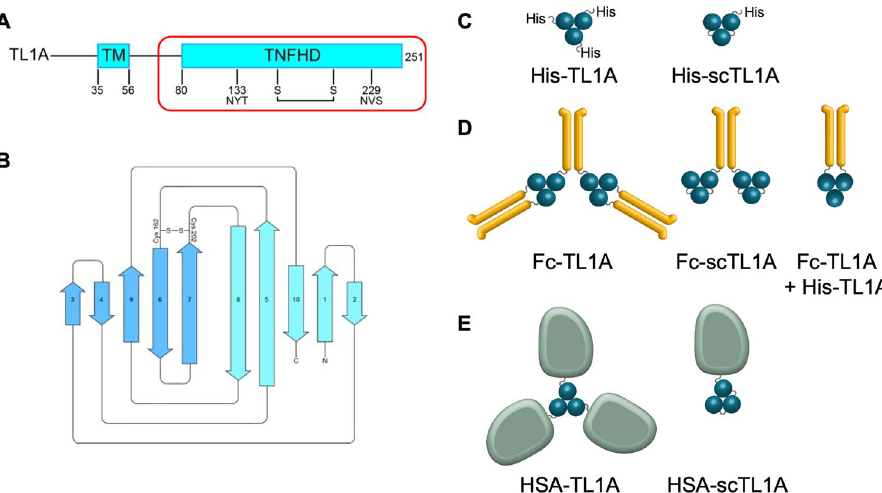
Figure 1. Several Architectures of TL1A Ligand were Evaluated. ( A ) TL1A is a type I transmembrane (TM) protein. Ligand designs focused on the C-terminal TNF homology domain (TNFHD), which contributes to binding to DR3 and DcR3. The positions of two N-linked glycosylation sites and disulfide bonds are indicated. ( B ) Secondary structure of the TNF homology jellyroll domain, which features ten anti-parallel b-strands which fold into a b-sandwich structure. Ligand designs fell into three categories: ( C ) His-TL1A or His-scTL1A, ( D ) Fc-TL1A, Fc-scTL1A, or Fc-His-TL1A, and (E) HSA-TL1A or HSA-scTL1A. Note that the Fc + His-TL1A molecule was generated by co-transfection of His-TL1A with Fc-TL1A at a molar DNA ratio of 1:2, and the desired product was purified by protein A and Ni–NTA tandem affinity chromatography. Images were